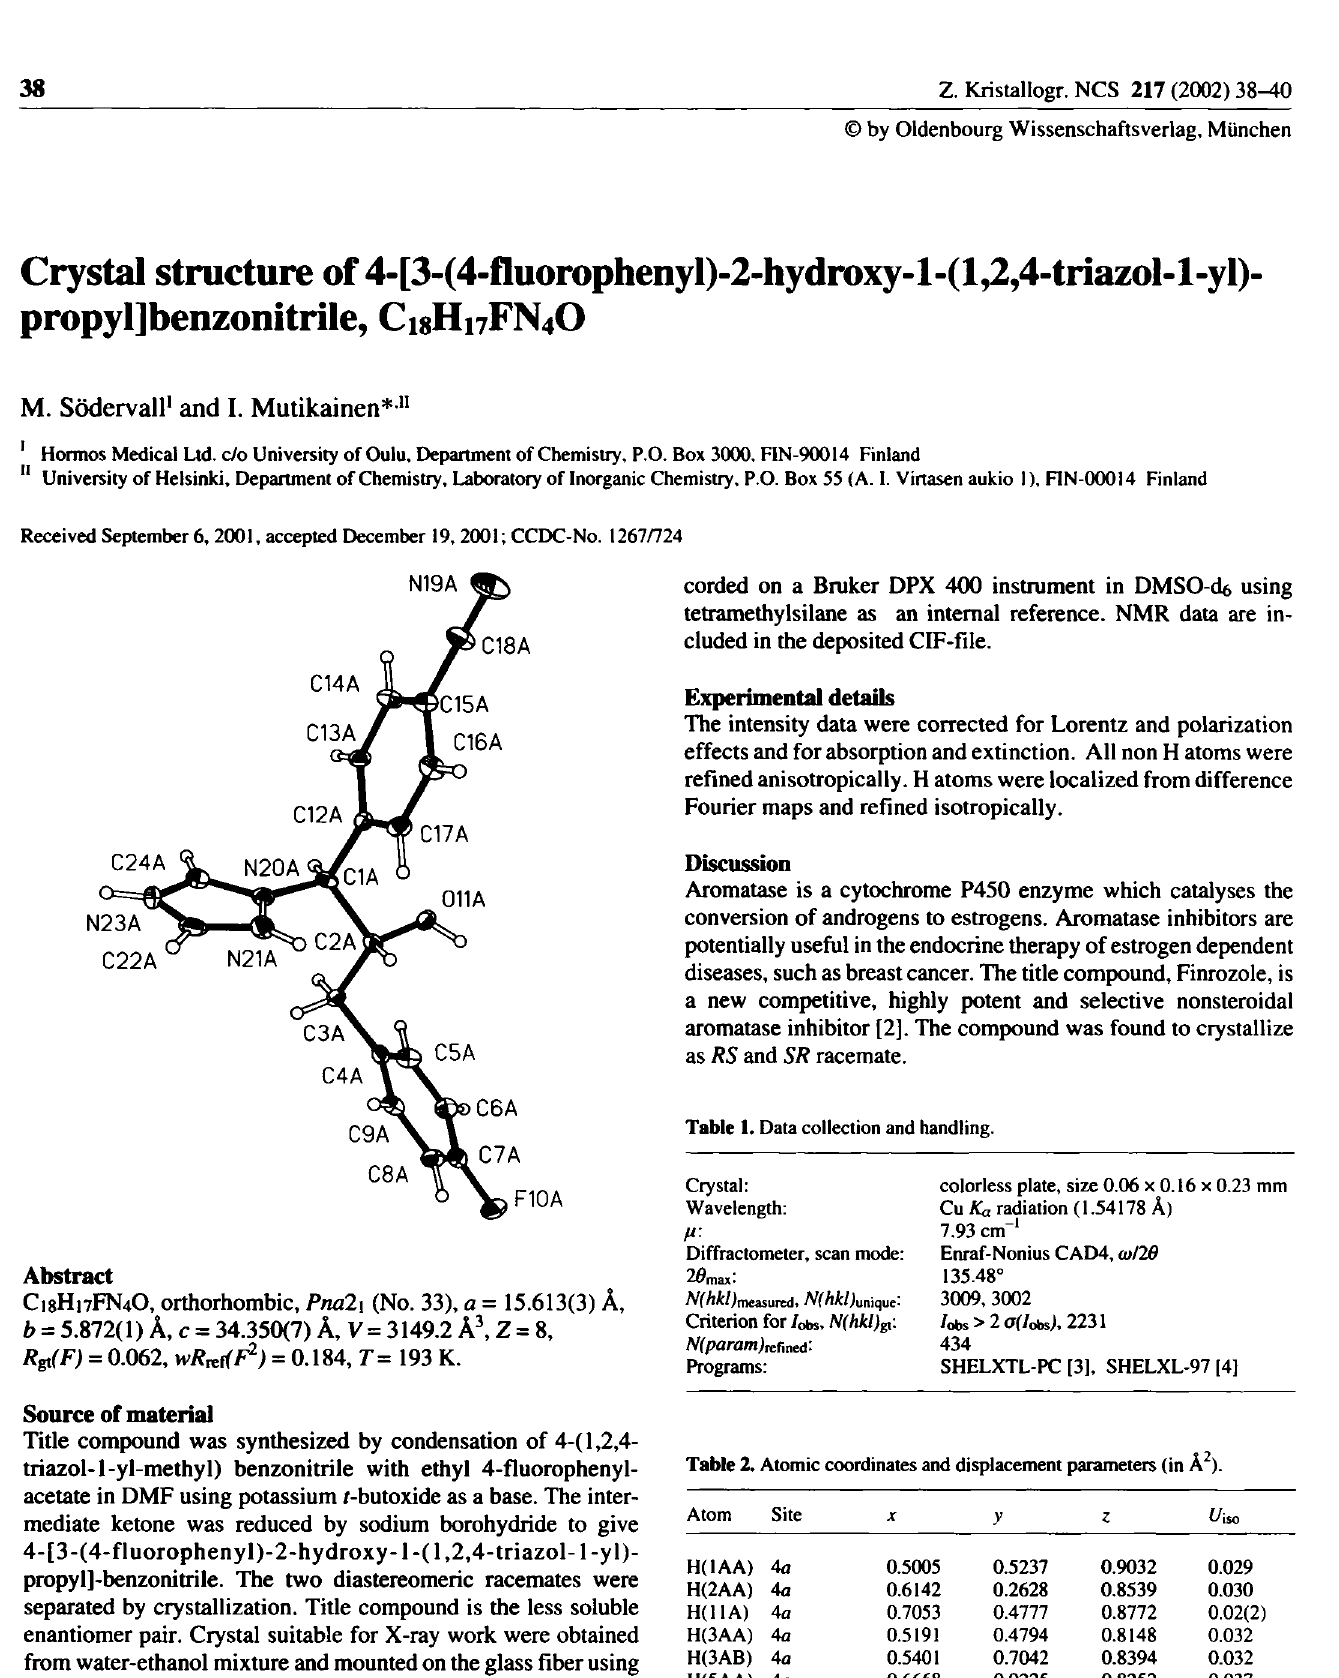
Table 2. Atomic coordinates and displacement parameters (in Â 2